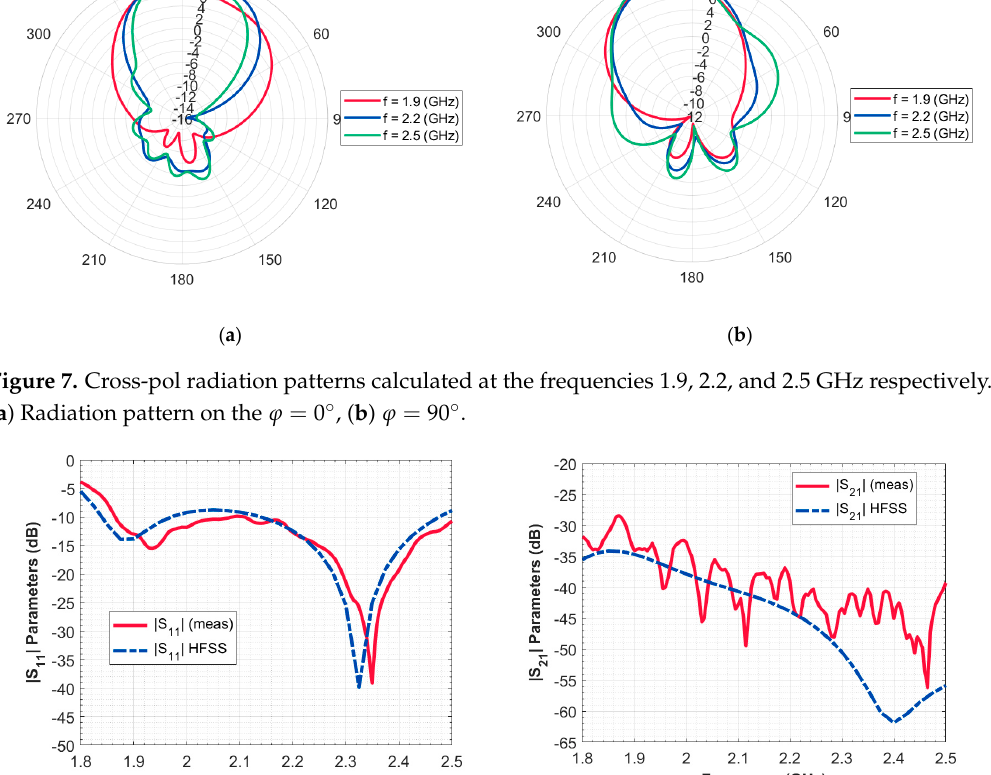
Figure 8. Comparison between simulated and measured scattering parameters of the E-shaped patch antenna. On the left ( a ) is shown | S 11 | vs. frequency, on the right ( b ) | S 21 | vs. frequency.